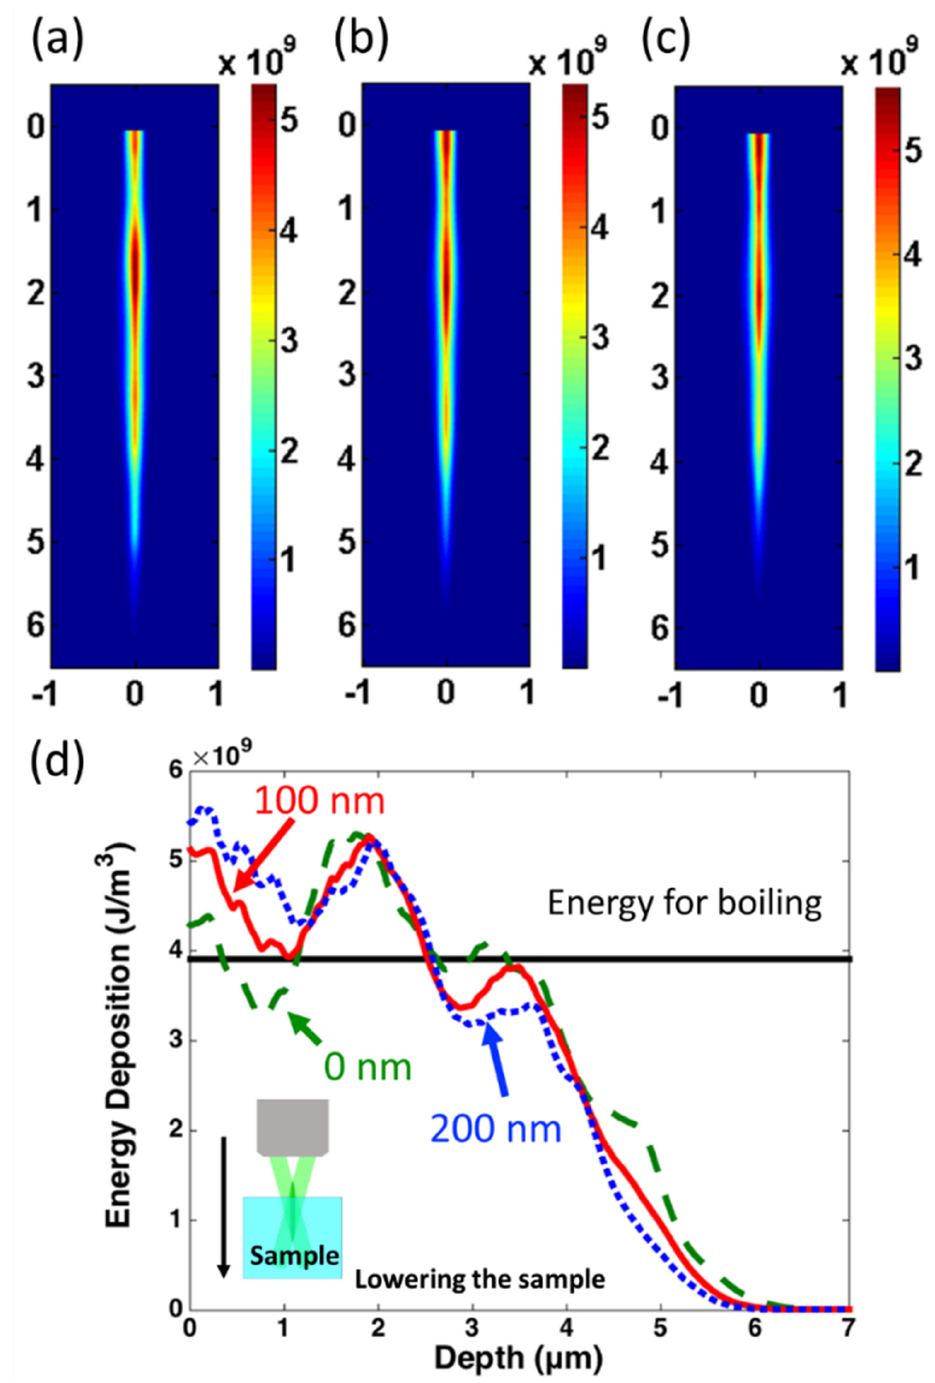
Figure 3. Simulation results for energy deposition by lowering the sample of ( a ) 0 nm, ( b ) 100 nm and ( c ) 200 nm along the beam propagation direction; tick label unit in ( a – c ): µ m, tick label unit for color bar: J/m 3 . The 0 nm position corresponds to the surface of the silica sample, ( d ) Energy deposition along the Bessel beam axis inside silica with different beam locations; green and dashed line: 0 nm; red and solid line: 100 nm; blue and dotted line: 200 nm; black and horizontal line: energy density for boiling.